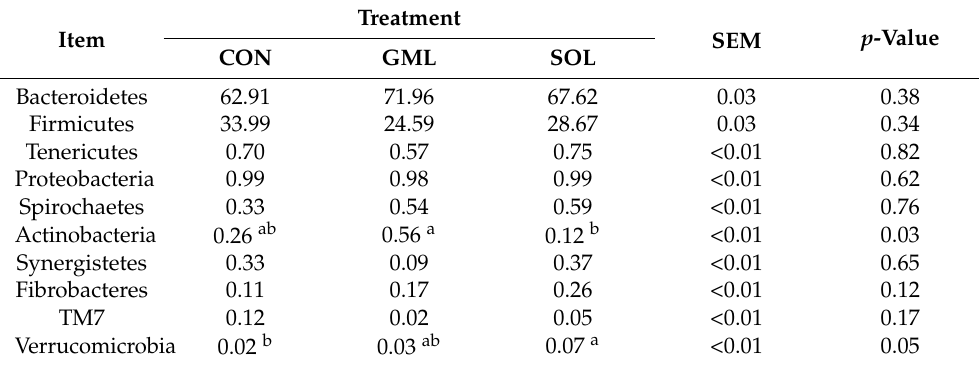
Table 5. Effects of monoglyceride laurate and Solider on the relative abundance of rumen microor- ganisms at the phylum level (%).